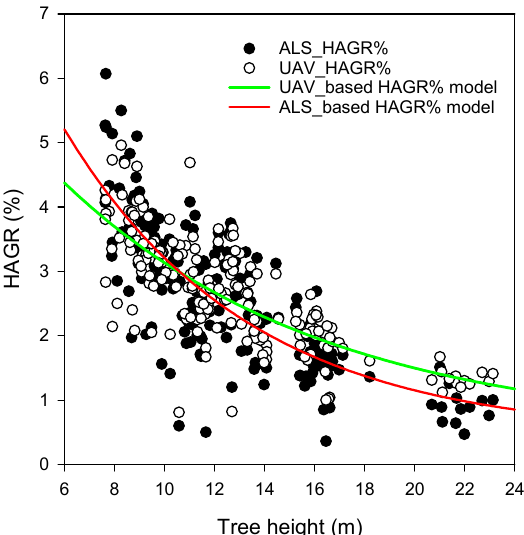
Figure 13. Dependency of the height annual growth rate estimates between the ALS and UAV ap- proaches.